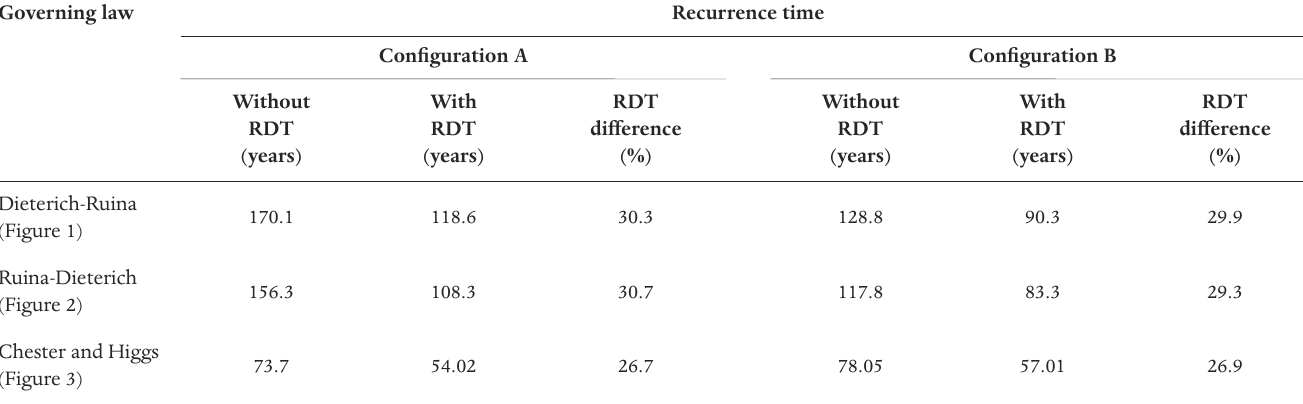
Table 2. Recurrence times for the different governing laws and the two configurations listed in Table 1. The last row in the table reports the cycle time variation, computed